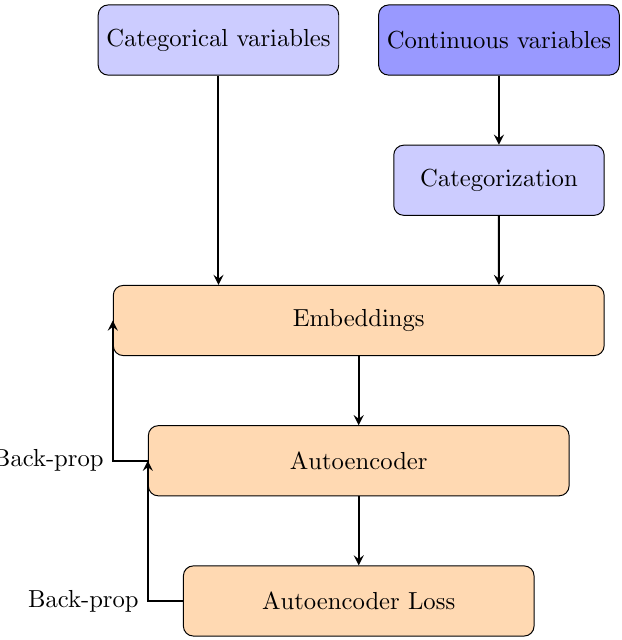
Figure 1. Architecture of